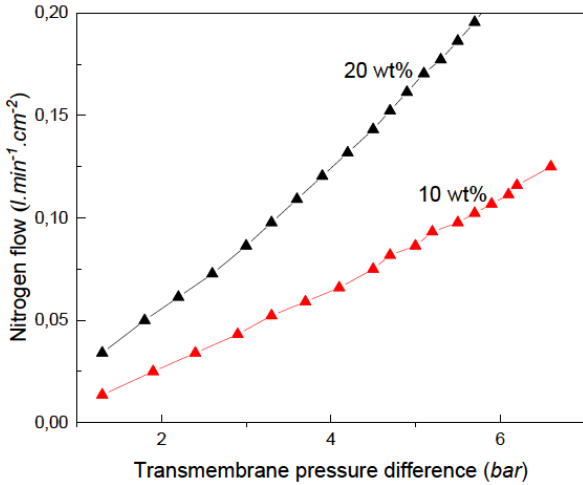
Figure 8: Nitrogen flow through the two studied MMMs (Polysulfone matrix with different zeolite loading) as a function of the transmem- brane pressure